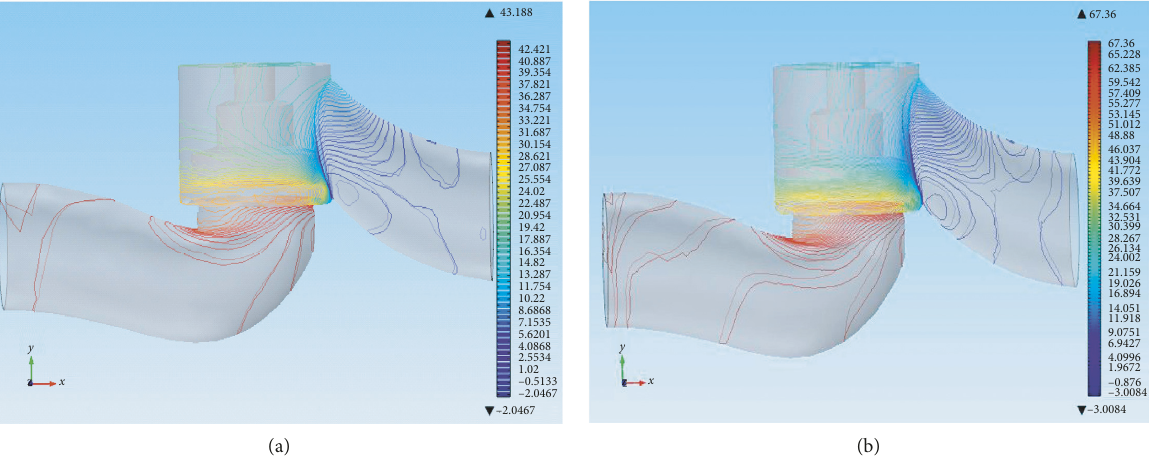
Figure 13: Pressure contours for p2 plug at different openings and v � 1m/s. (a) 10% valve opening; (b) 20% valve